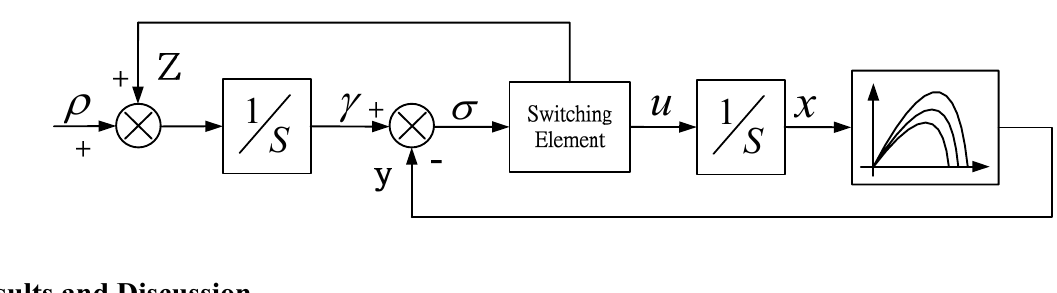
Figure 11. A block diagram of a sliding mode ESC system.